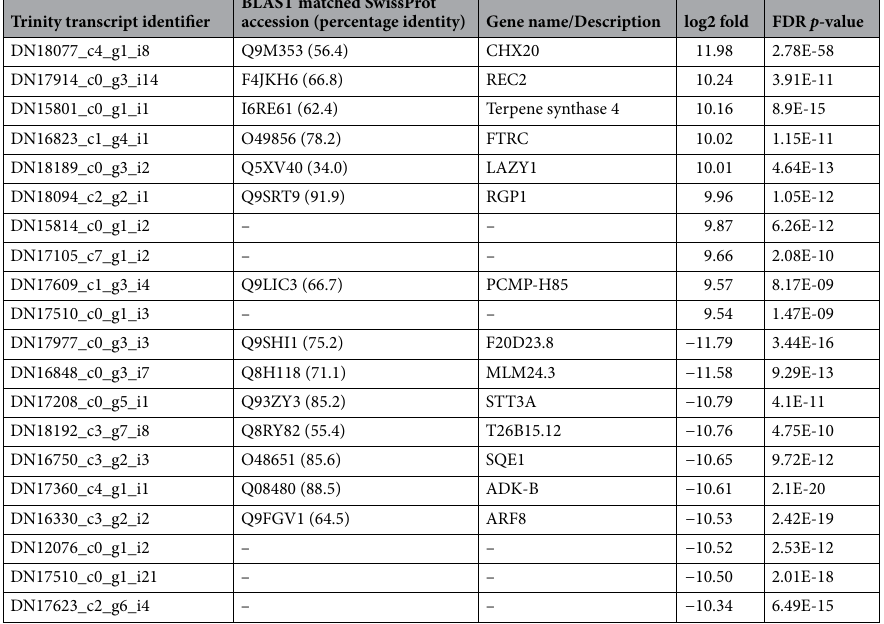
Table 5. Top 20 differentially expressed transcripts between blue and white light treated samples. Positive and negative fold changes indicate up- and down-regulation, respectively, in blue light compared to white light exposed samples.